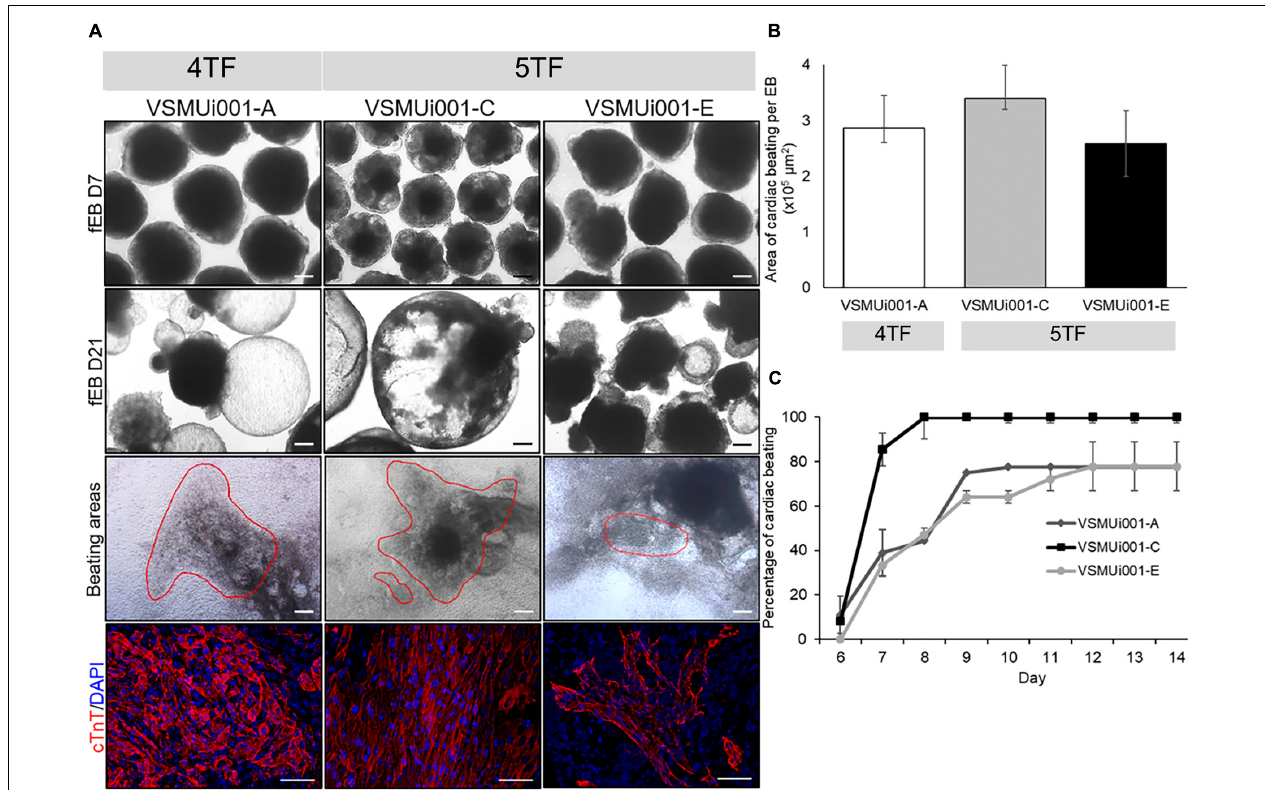
FIGURE 6 | In vitro cardiogenic differentiation of various porcine-induced pluripotent stem cell lines. (A) Morphology of floating embryoid bodies (fEB) at days 7 and 21, area of cardiac beating (scale bar, 100 µ m), and cTnT expression of VSMUi001-A, VSMUi001-C, and VSMUi001-E; scale bar, 50 µ m. (B) Area of cardiac beating per embryoid body. (C) Percentage of spontaneous cardiac beating. 4TF, induction using OCT4, SOX2, KLF4, and C-MYC; 5TF, induction using OCT4, SOX2, KLF4, C-MYC, and LIN28; cTnT, cardiac troponin T.